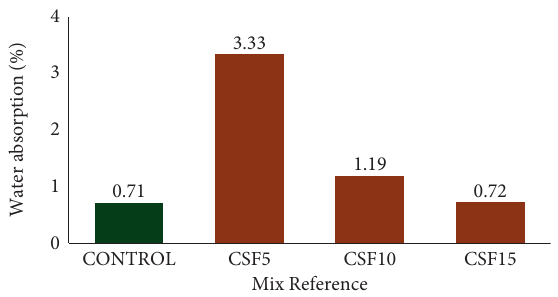
Figure 20: Water absorption values of CSF.